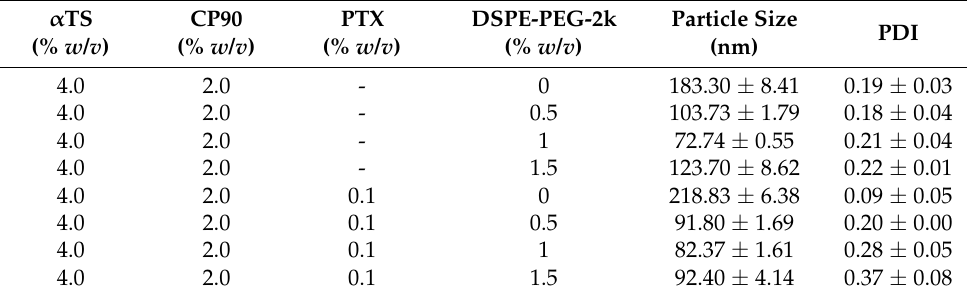
Table 6. Formulations for optimization of